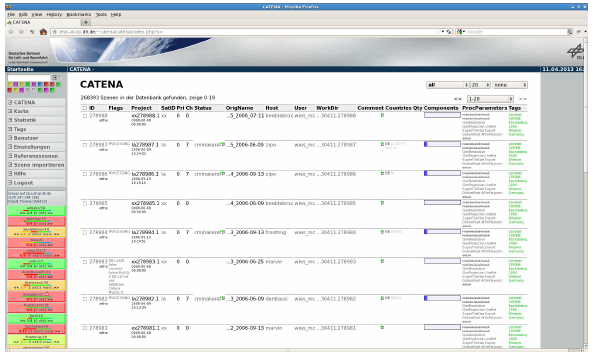
Figure 4: Local Control as CATENA web-interface showing all finished, processing and unfinished tasks in the database. On the left side the involved hosts are colorfully shown (green: waiting for new tasks, red: no node available, orange: all available nodes on host are processing, yellowish green: nodes are processing on this host, but there are still free nodes)